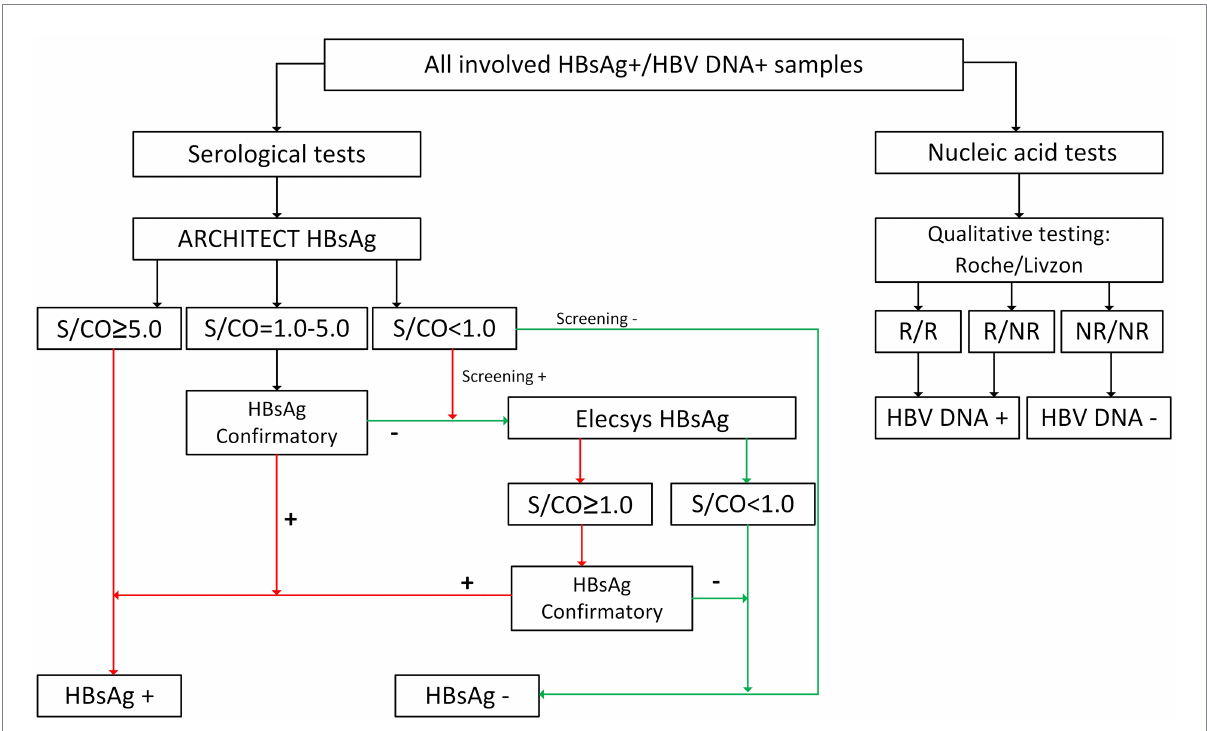
FIGURE 2 Confirmatory process of HBsAg and HBV DNA. +, reactive/positive; − , nonreactive/negative; R, reactive; NR, nonreactive; ARCHITECT HBsAg, ARCHITECT HBsAg Qualitative II (Abbott Ireland Diagnostics Division, Sligo, Ireland); Elecsys HBsAg, Elecsys HBsAg II (Roche Diagnostics GmbH, Mannheim, Germany). HBsAg Confirmatory, ARCHITECT HBsAg Qualitative II Confirmatory (Abbott Ireland Diagnostics Division), or HBsAg Confirmatory Test (Roche Diagnostics GmbH). Roche, cobas TaqScreen MPX Text, version 2.0 (Roche Molecular Systems, Inc., Branchburg, NJ, United States); Livzon, HBV DNA/HCV RNA/HIV-(1 + 2) RNA Diagnostic Kit (PCR- Fluorescence Probing) (Livzon Diagnostics, Zhuhai,